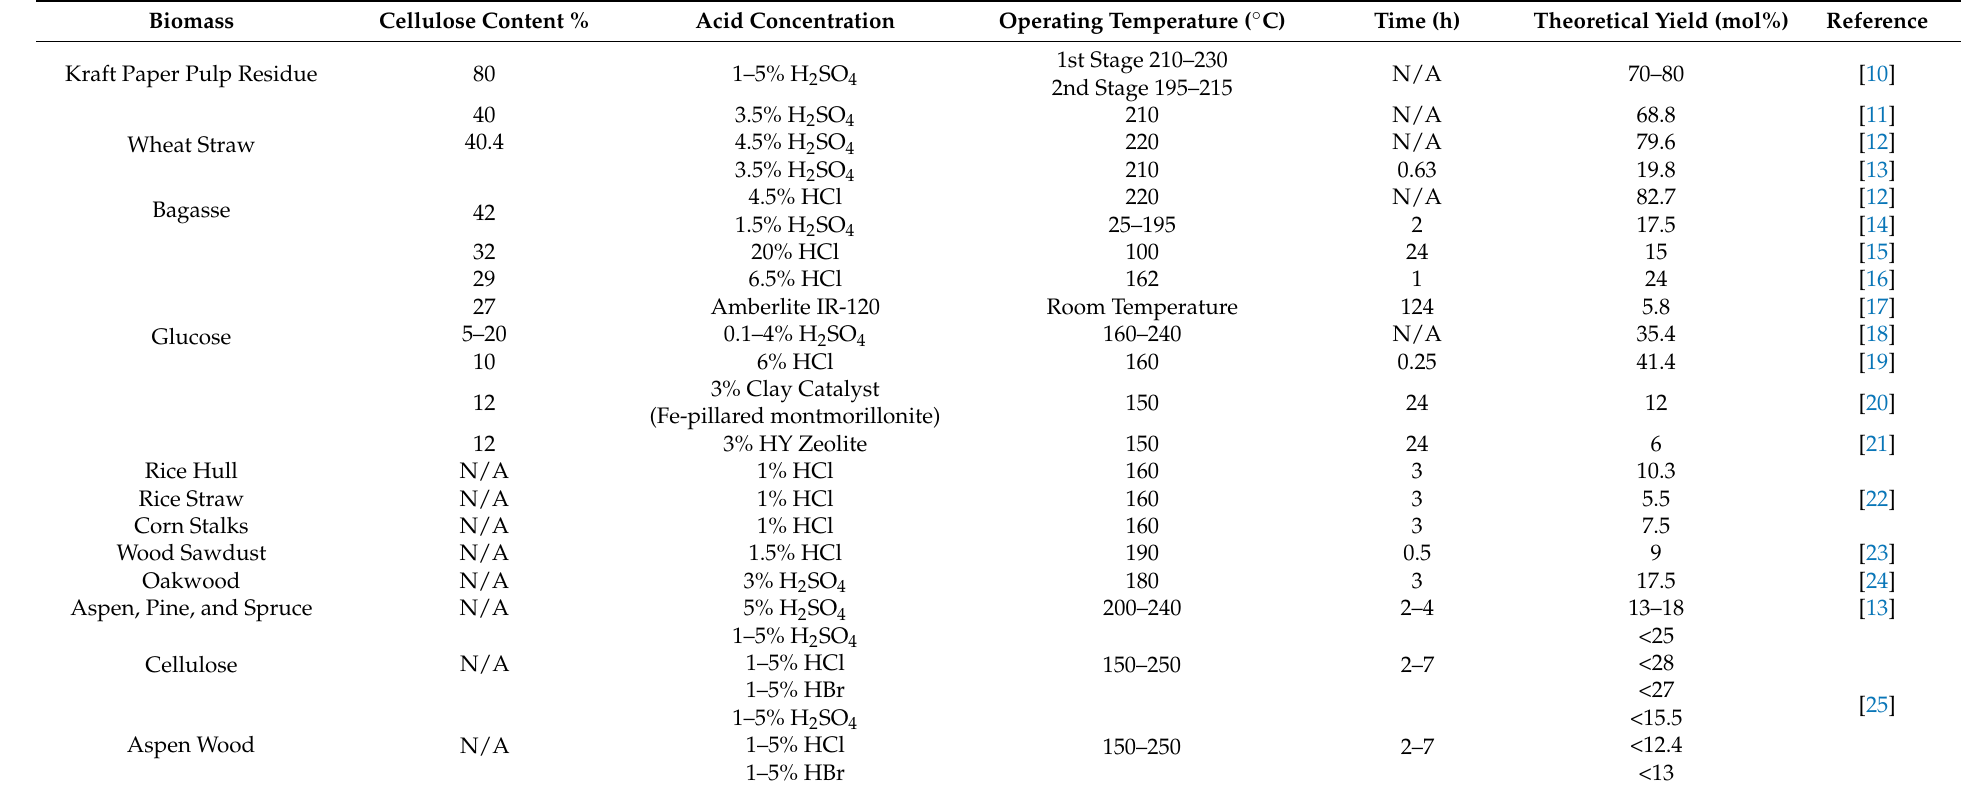
Table 1. Review of extraction methods for levulinic acid from lignocellulosic